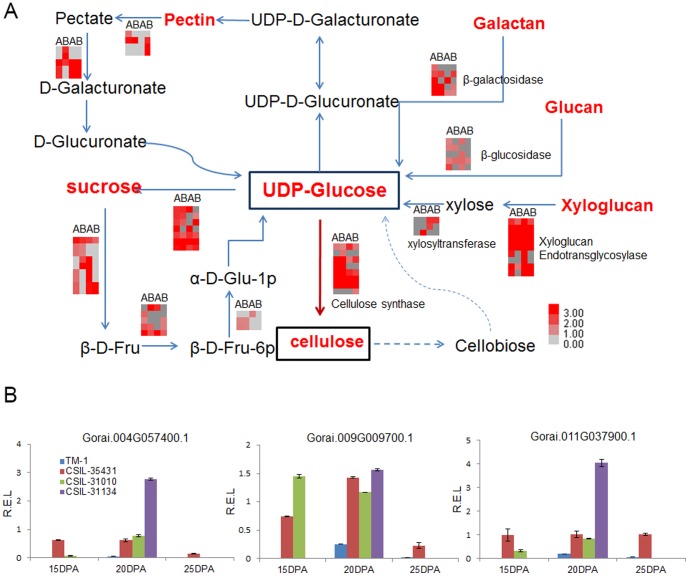
Carbohydrate pathways that are differentially regulated during the secondary cell wall synthesis stage.(A) Carbohydrate pathways. Genes up-regulated in CSIL-315431 and CSIL-31010 were selected to do heat map. ABAB indicated DEGs in CSIL-35431 at 15 DPA, CSIL-35431 at 20DPA, CSIL-3010 at 15DPA and CSIL-31010 at 20DPA, from left to right. Every square stand for one gene and every line stand for the same gene. Genes with red color expressed higher in CSILs than TM-1 and gray color stand for no difference. β-D-Fru, β-D-Fructose; α-D-Glu-1p, α-D-Glucose-1-phosphate; β-D-Fru-6p, β-D-Fructose-6-phosphate. (B) Quantitative RT–PCR validation of four CesA genes in CSILs and TM-1, Gorai.004G057400.1, Gorai.009G009700.1 and Gorai.011G037900.1 homologous with AtCESA4, AtCESA7 and AtCESA8, respectively.